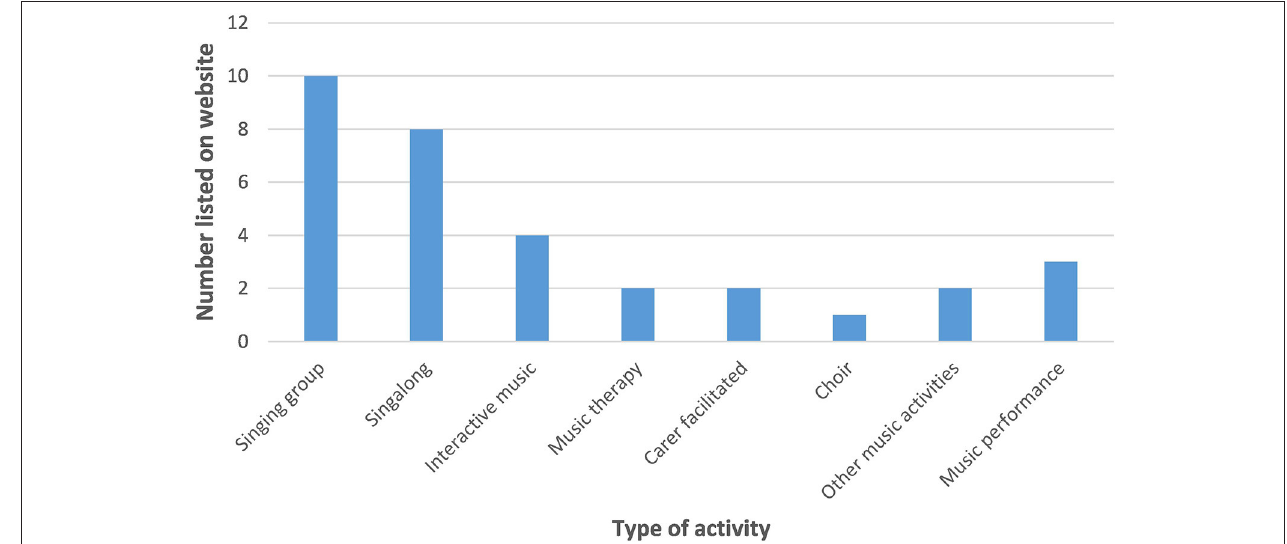
FIGURE 1 | Online music activities for people with dementia listed on Music for Dementia website (July 2020).